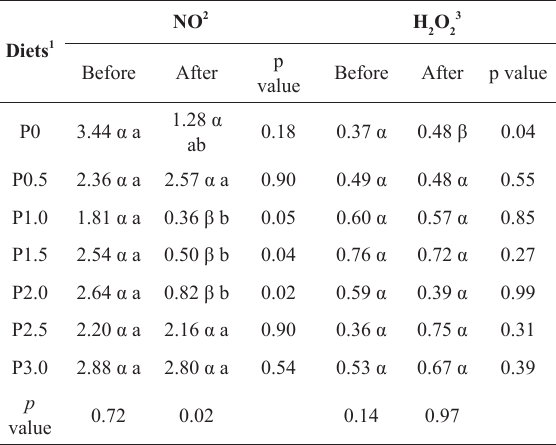
Reactive nitrogen and oxygen intermediates of Nile tilapia fed graded levels of dietary crude propolis powder, before and after challenge with A. hydrophila